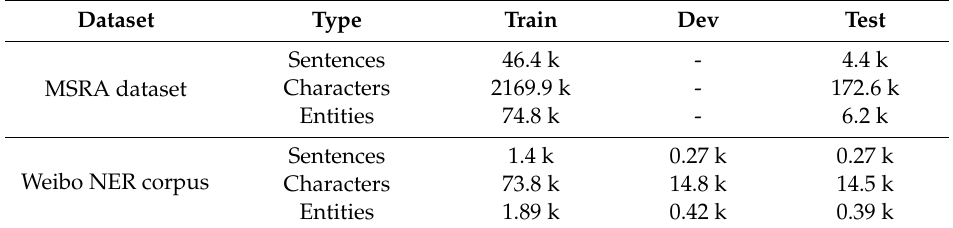
Table 1. Microsoft Research Asia (MSRA) dataset and Weibo NER (Named Entity Recognition) corpus detailed